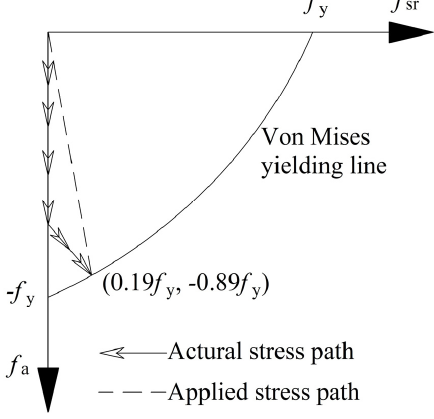
Figure 12. Curve of hooping and longitudinal stresses of steel tube.